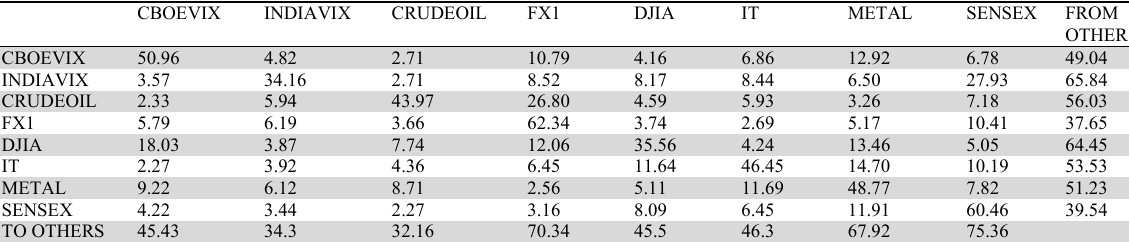
Diebold-Yilmaz Spillover at D4